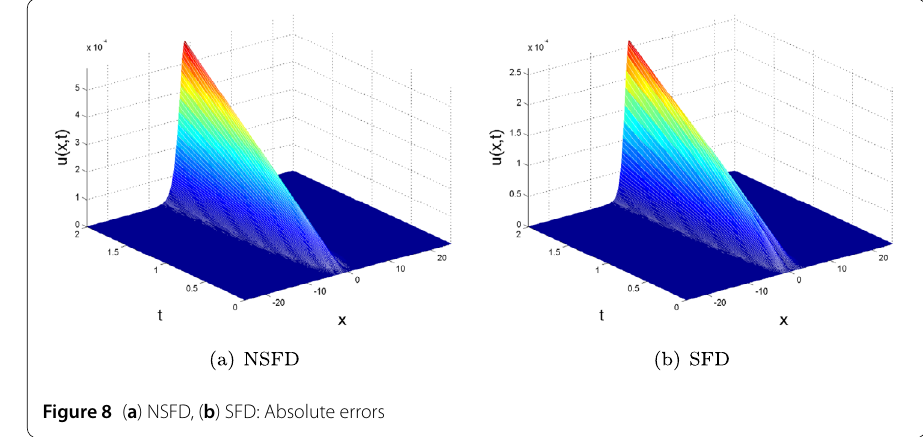
Figure 8 ( a ) NSFD, ( b ) SFD: Absolute